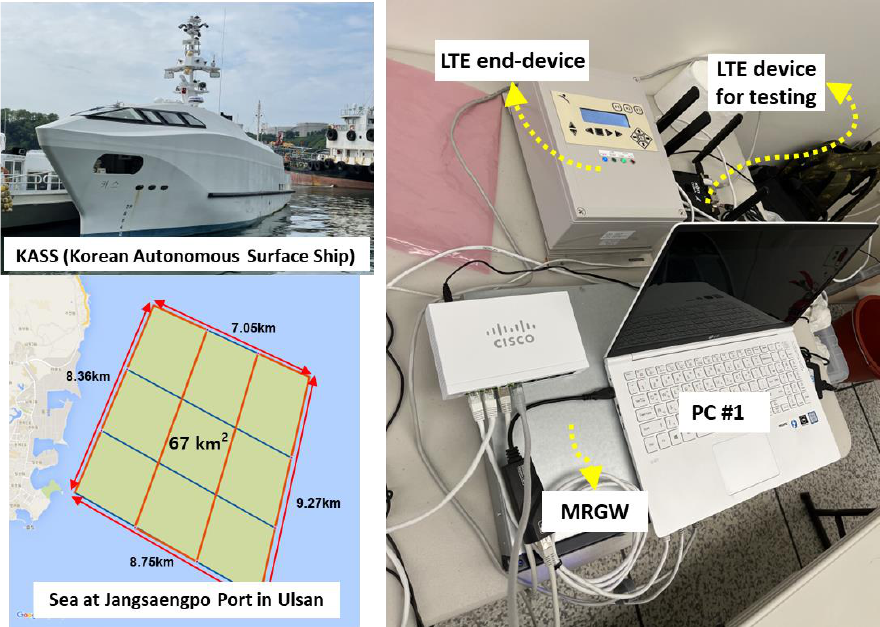
Figure 7. Experimental environment for testing MRGW and LTE end-device in the testbed of KASS at Jangsaengpo port in Ulsan, Republic of Korea.